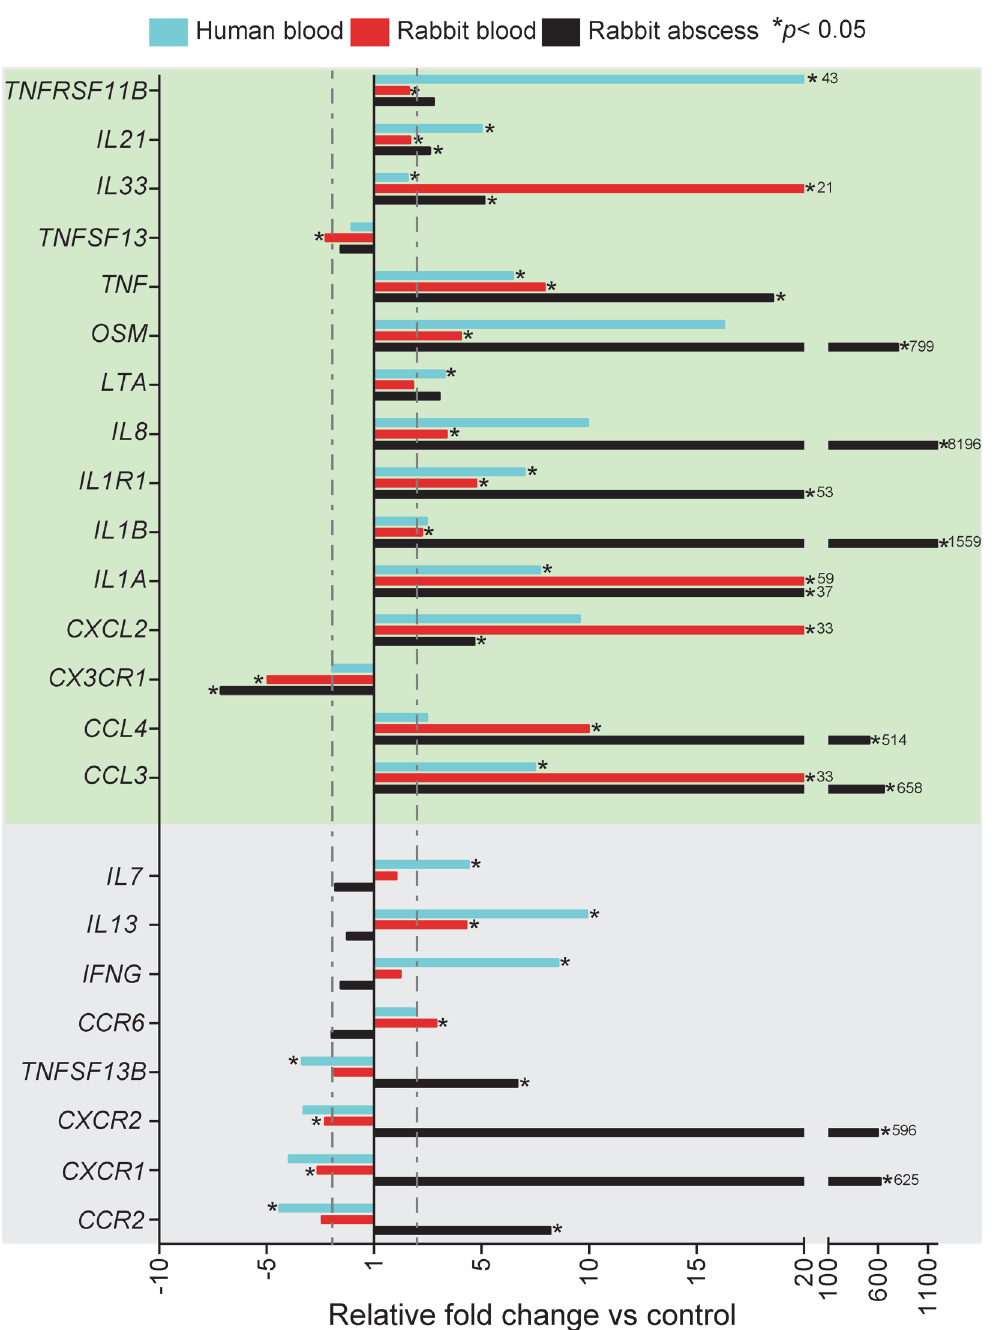
Fig 3. Real-time PCR analyses of the host inflammatory response to S . aureus . Transcript levels in 24 h rabbit abscess samples are presented as fold change relative to those in healthy skin. Results are the average fold-change of 3 abscesses. Changes in human and rabbit blood transcript levels following culture with S . aureus (10 7 CFU/ml) are expressed as average fold change relative to transcript levels in heparinized blood alone (no bacteria) (S2 and S3 Tables). All blood samples were incubated for 2 h at 37°C and results are average of three blood donors. Relative transcript levels of molecules within the green box increased or decreased coordinately in all conditions tested. Transcript levels of the molecules in the grey box are discordant between blood and abscess tissue. The dotted lines indicate a 2-fold change in expression compared to control samples. * P < 0.05 versus control samples using a two-tailed equal variance